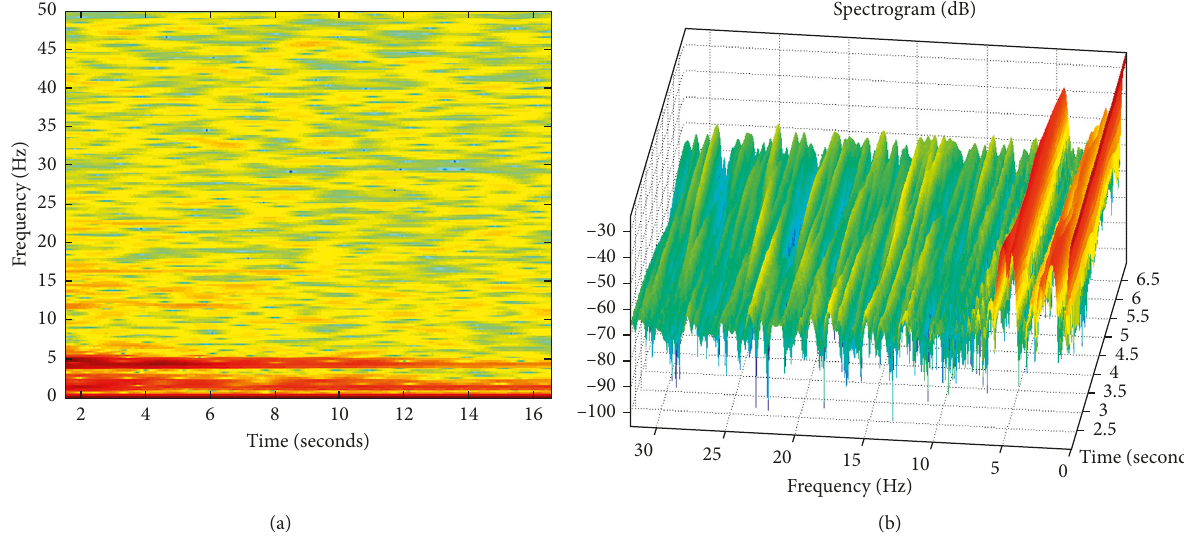
Figure 5: Spectrum of the tiltmeter signal of bearing: (a) spectrogram and (b) 3D